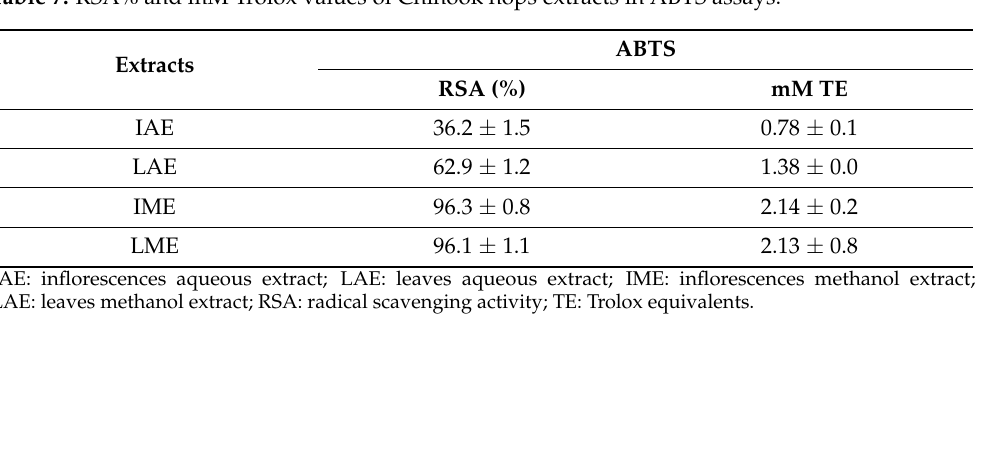
Table 7. RSA% and mM Trolox values of Chinook hops extracts in ABTS